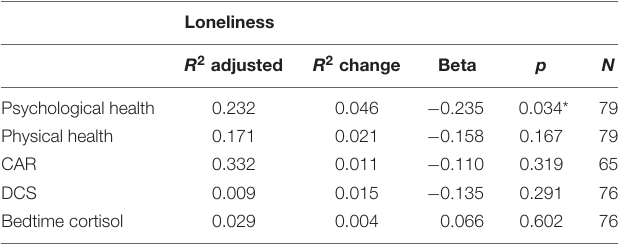
TABLE 3 | Adjusted regression analyses with loneliness as a predictor and the psychological and physical health and cortisol indexes as dependent variables.